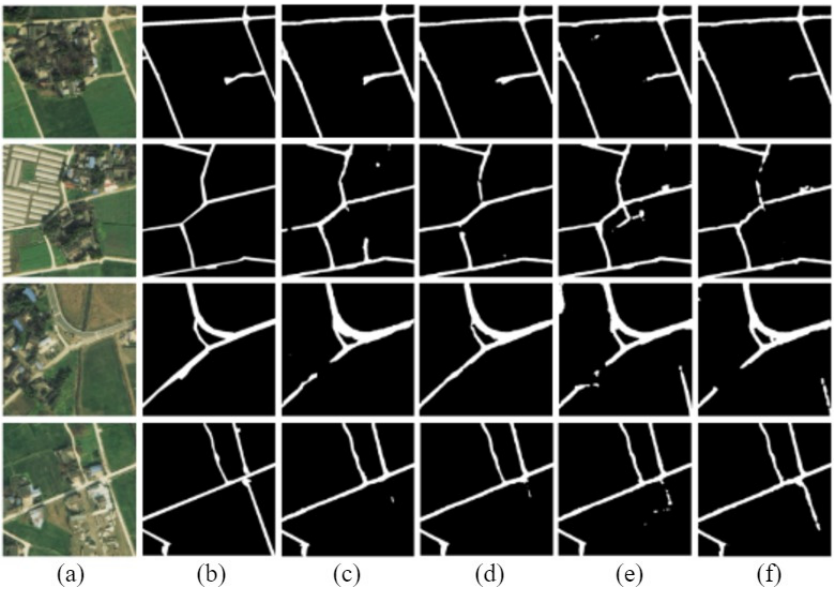
Figure 15. Comparison results of general scene experiments. ( a ) Input image; ( b ) label image; ( c )D-